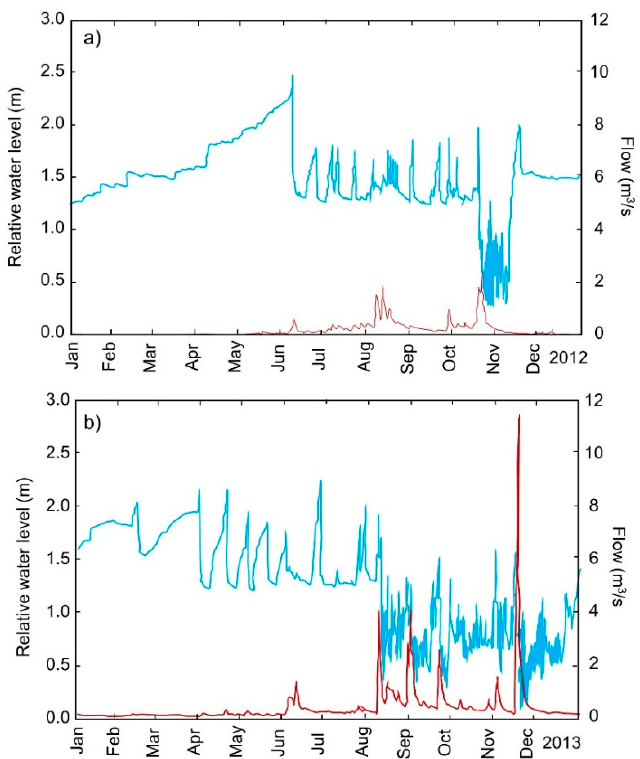
Figure 7. Relative water level (m) (blue line) and freshwater inflow (m 3 s − 1 ) (red line) measured at the Onrus Estuary in 2012 ( a ) and 2013 ( b ).